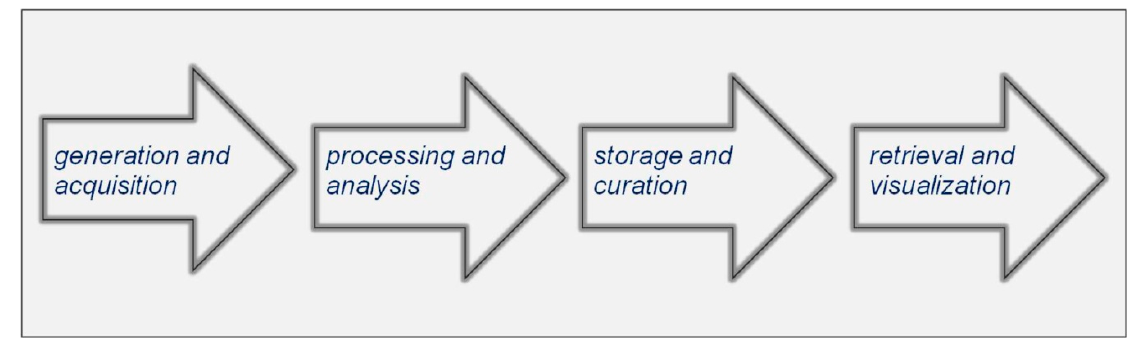
Figure 1. The big data value chain [1]. All steps in the chain, from data generation to retrieval and visualization for exploitation to the benefit of science, business, and society, are subject to problems relative to the volume , variety , velocity, and veracity of the data, affecting their ultimate value to science and society ( 5-‘v’ problem ).